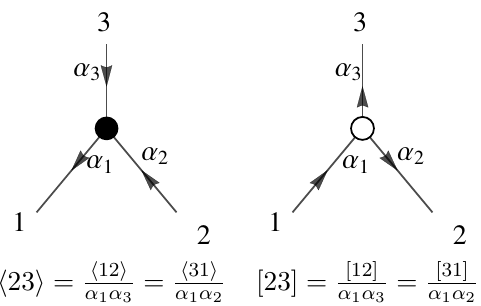
Figure 21 . Relations between spinor bracket factors at each vertex of an on-shell diagram in N = 8